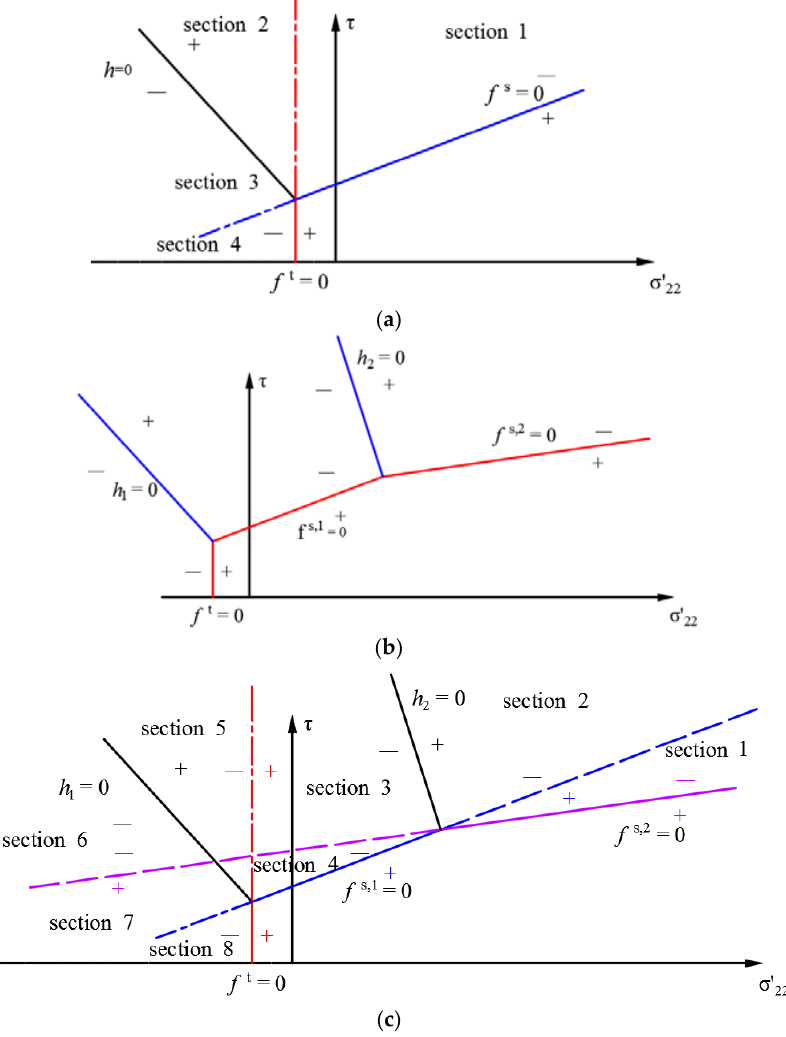
Figure 10. Two kinds of joint failure criteria for a jointed rock mass. ( a ) Joint failure criterion for constellations 1–4 (see Table 1); ( b ) Multi-stage failure criteria for joints having different parameters; ( c ) Eight sections for solving the multi-surface plasticity problem.